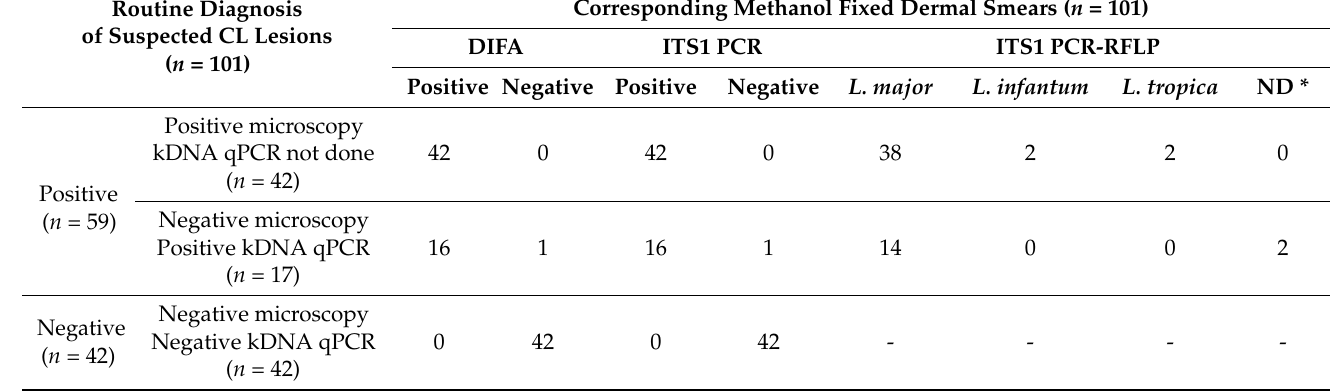
Table 1. Results of direct immunofluorescence assay and ITS1 PCR-RFLP on dermal smears from suspected CL